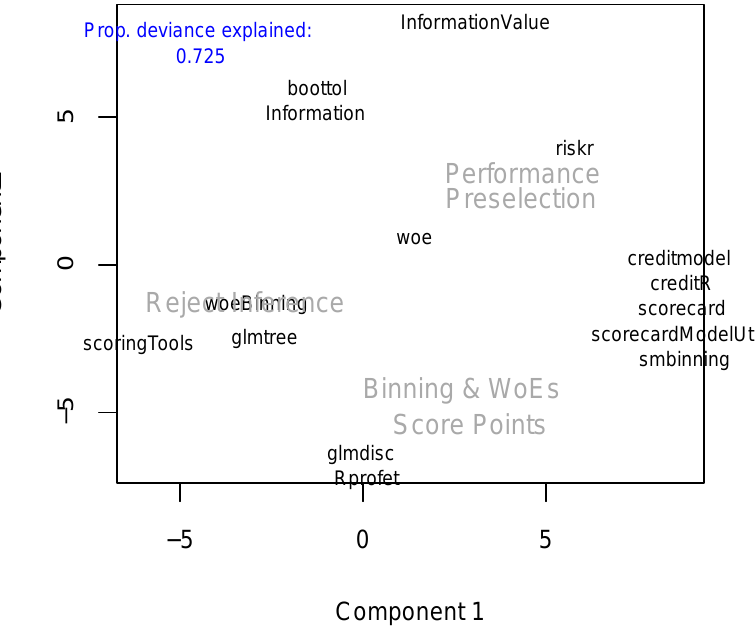
Figure 5. Landscape of R packages for scorecard modelling using logistic